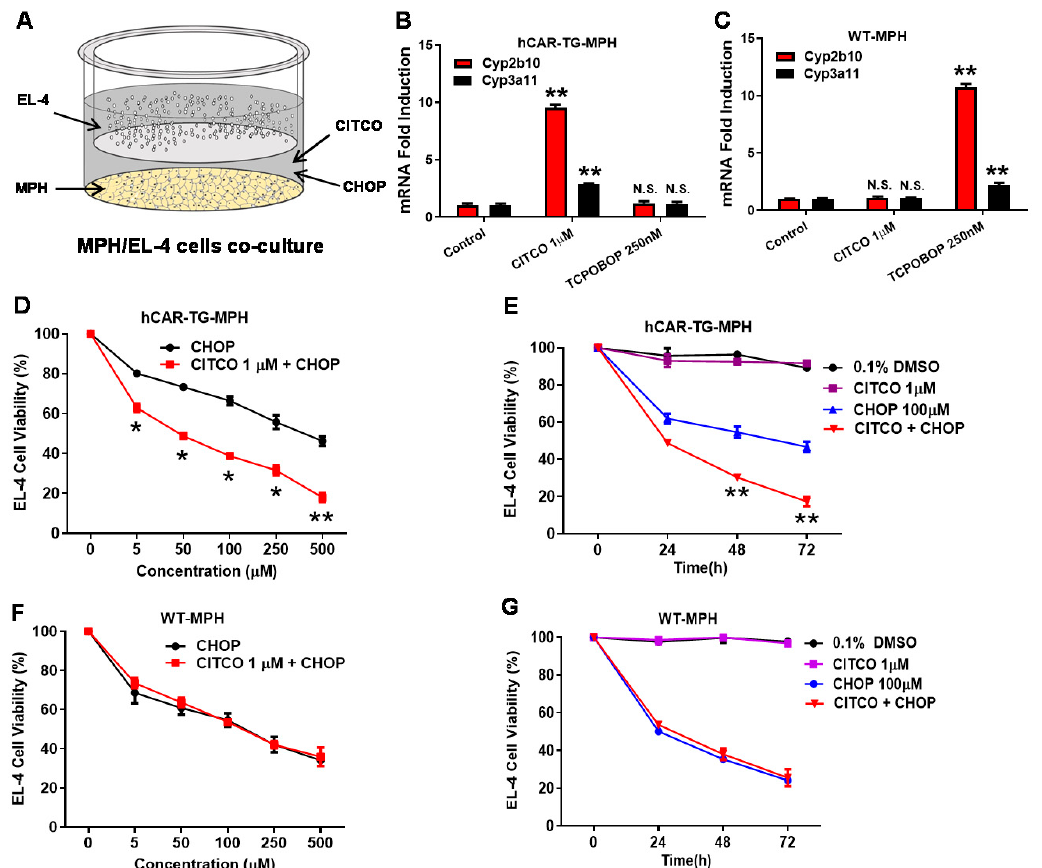
Figure 1. CITCO increases CHOP-mediated cytotoxicity in EL-4 cells co-cultured with hCAR-TG-MPH, not WT-MPH. ( A ) Schematic depiction of the co-culture model. ( B , C ) Cultured hCAR-TG-MPH and WT-MPH were treated with vehicle control (0.1% DMSO), CITCO (1 µM), or TCPOBOP (250 nM) for 24 h. The expression of Cyp2b10 and Cyp3a11 was measured by RT-PCR. ( D , E ). The co-culture of EL-4/hCAR-TG-MPH was treated with vehicle control (0.1% DMSO), CITCO (1 µM), CHOP at indicated concentrations, or CITCO + CHOP in a concentration- or time-dependent manner. EL-4 cell viability was measured as indicated in Materials and Methods. ( F , G ). The co-culture of EL-4/WT- MPH was treated as described above, and EL-4 cell viability was monitored. Data represent Mean ± SD from three independent experiments as a percentage of vehicle control. *, p < 0.05; **, p < 0.01, N.S.,